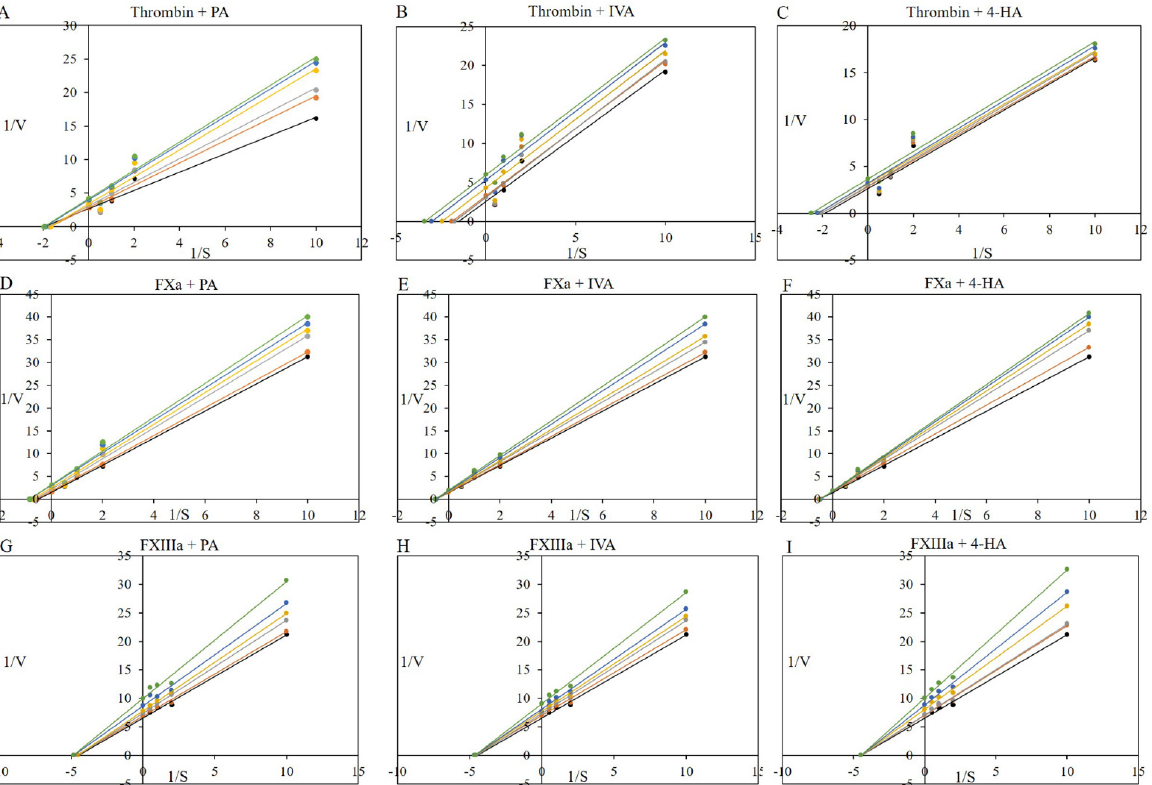
Figure 4. Kinetic and inhibitor studies for thrombin, FXa, and FXIIIa. Lineweaver—Burk plots were used for the inhibition of target enzymes. The plots are expressed as 1/velocity (1/V) versus 1/substrate (1/[S]) with or without each compound (non-treated (black circle), 0.065 (orange circle, 1 μg), 0.13 (silver circle, 2 μg), 0.325 (yellow circle, 5 μg), 0.65 (blue circle, 10 μg), and 1.3 mM (green circle, 20 μg)) as an inhibitor against thrombin ( A – C ),